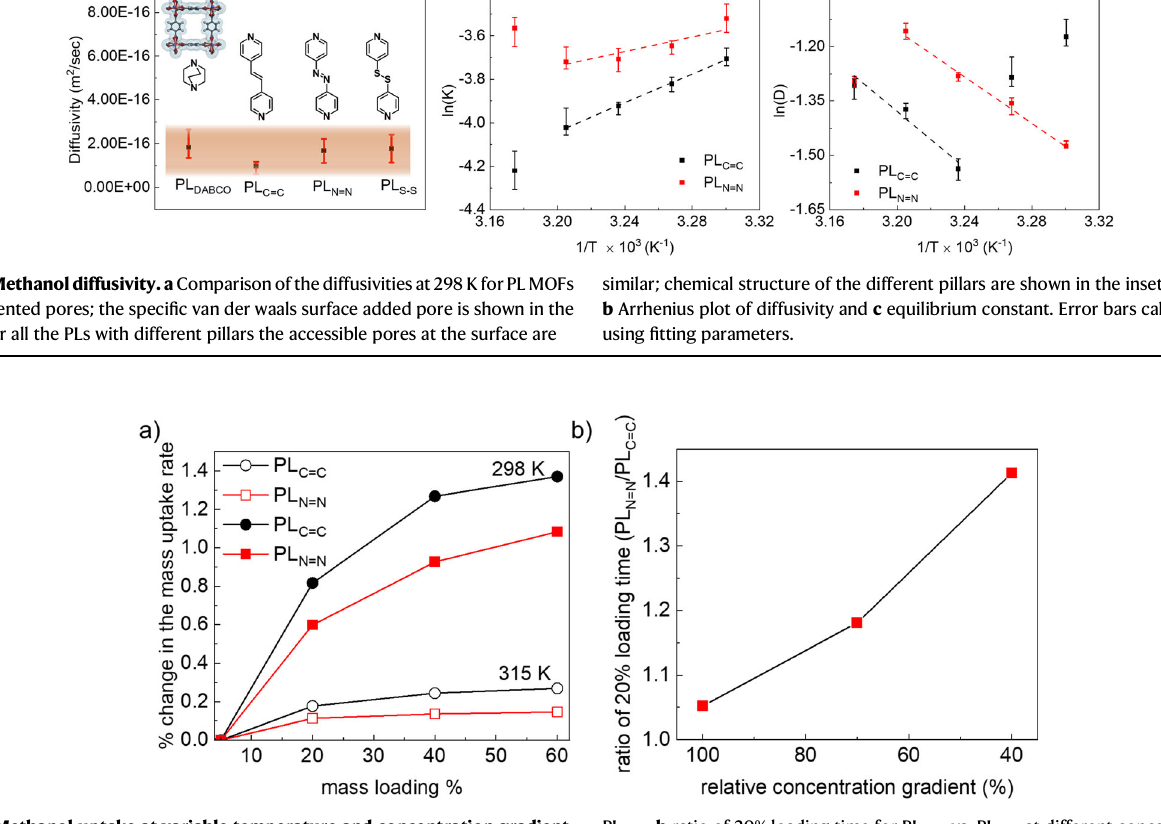
PL N=N , b ratio of 20% loading time for PL N=N vs. PL C=C at different concentration gradient controlled by varying nitrogen fl ow. (See source data for